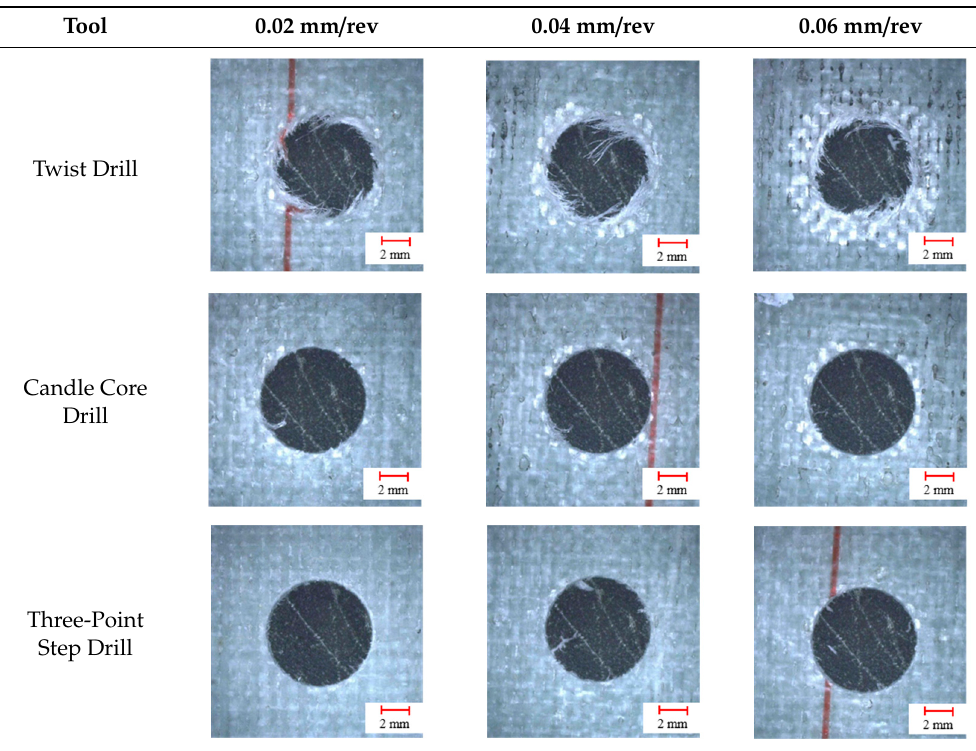
Table 2. Damage pictures of the outlets of the holes.